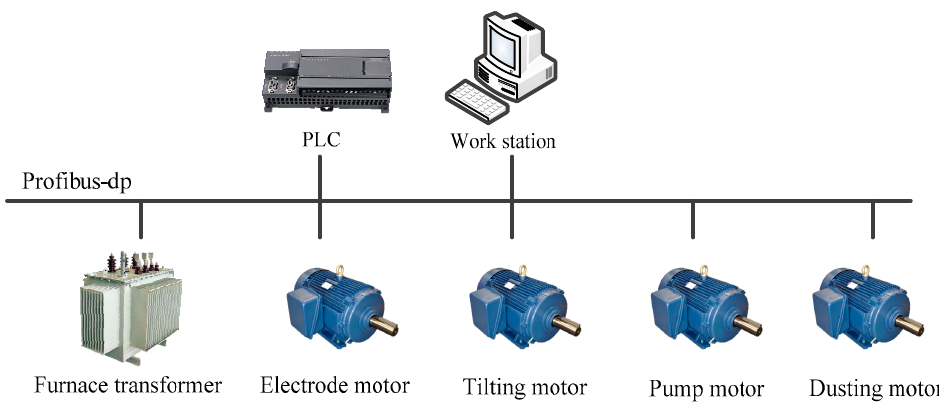
Figure 3. Schematic diagram of the electrical control system.